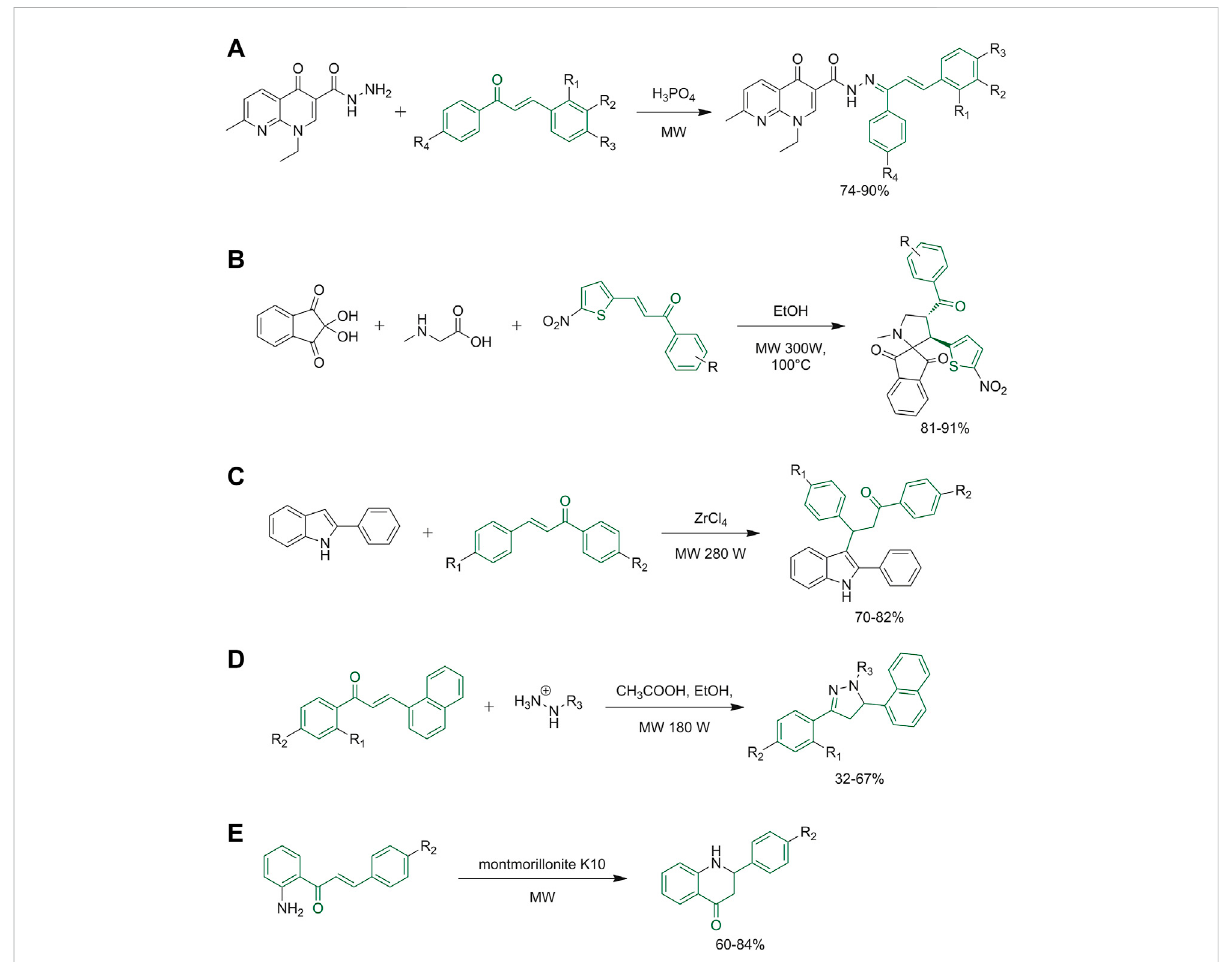
FIGURE 8 (A) Synthetic step of N ′ -(1,3-diphenylallylidene)-1-ethyl-7-methyl-4-oxo-1,4-dihydro-1,8-naphthyridine-3-carbohydrazide derivatives; (B) synthesis of novel spiropyrrolidine derivatives; (C) synthesis of 3-(3-oxoaryl) indole derivatives; (D) synthesis of pyrazoline derivatives; (E) the fi nal step to synthesize 2-aryl-2,3-dihydroquinolin-4(1 H )-ones by microwave